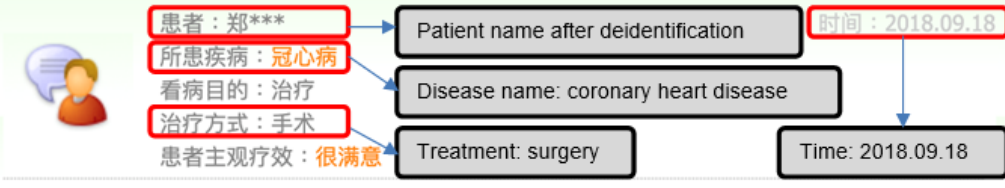
Figure 1. Screenshot of a review on the Good Doctor website.